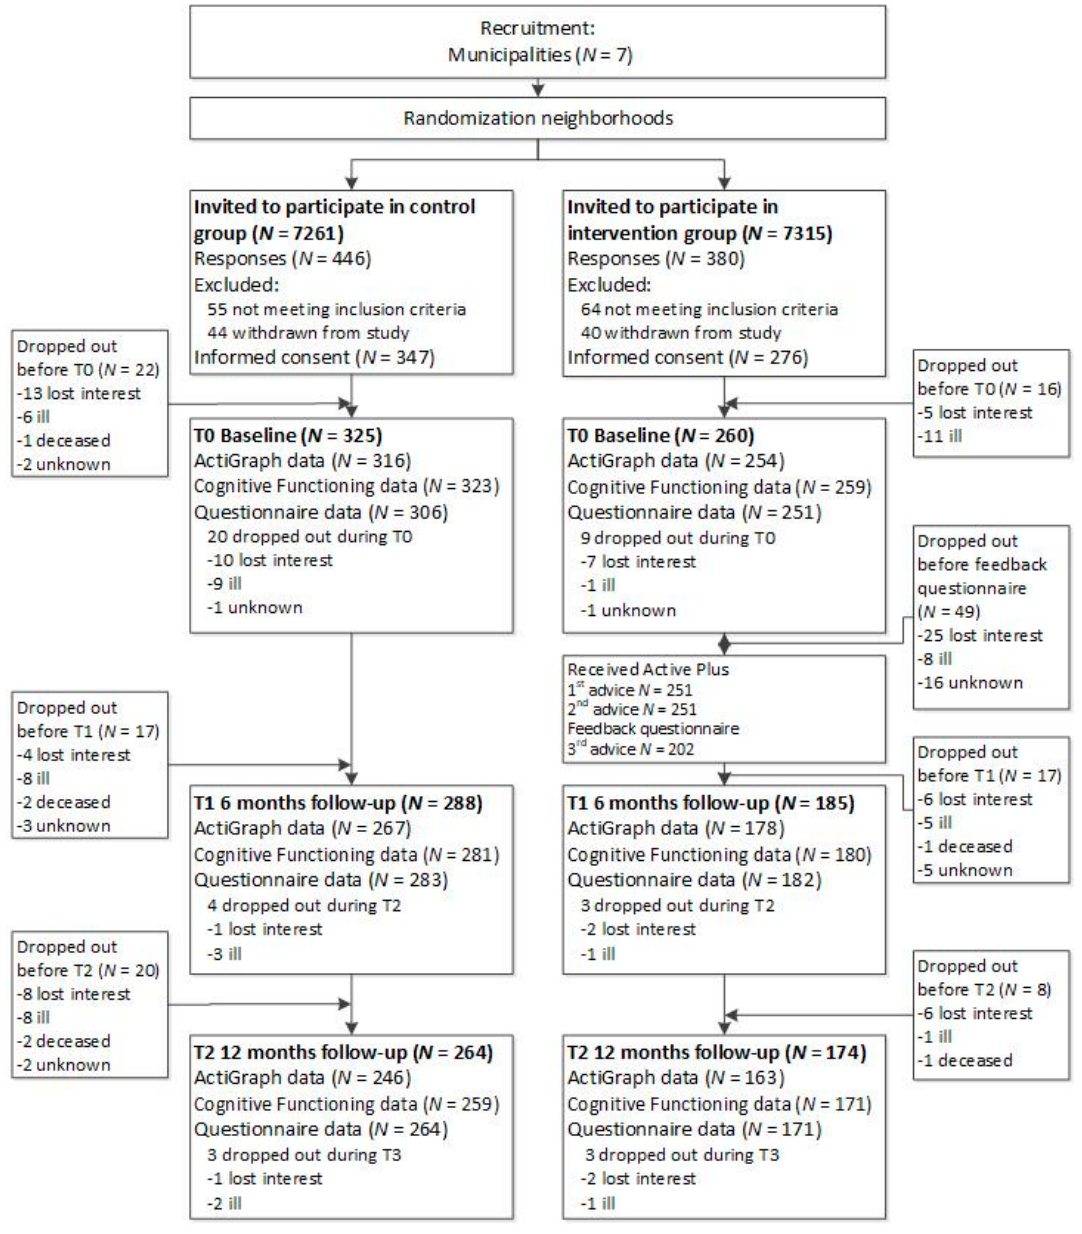
Figure 1. Flow diagram of the study.